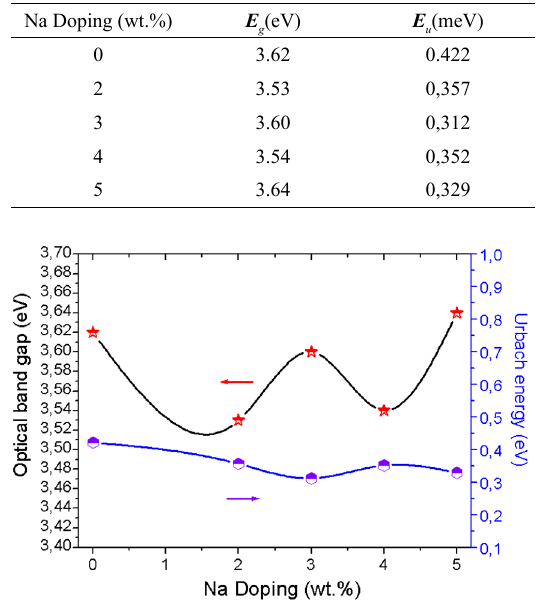
Figure 6. The variation of optical band gap and Urbach energy of Na doped NiO thin films as a function of doping level.